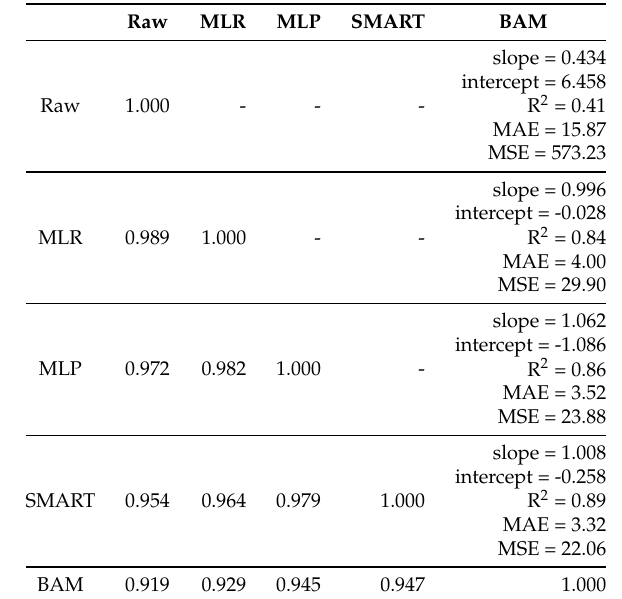
Table A3. Correlation coefficient and metrics of low-cost sensor and governmental BAM (after calibration).